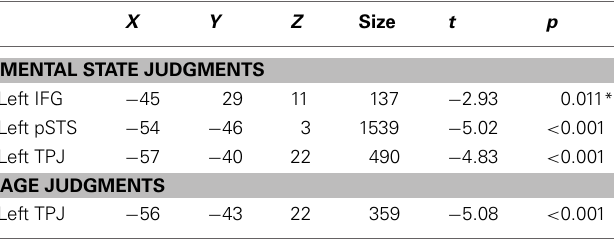
Table 3 | Activation during mental state judgments and age judgments post-ASI vs. post-GSI.